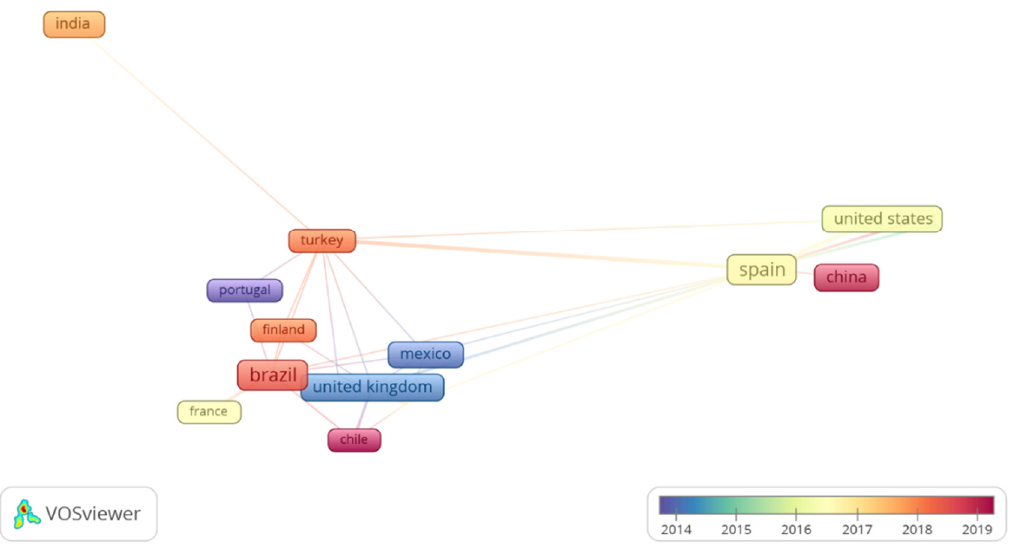
Figure 2. Visualization map of the collaboration network of countries according to co-occurrence over the years. Each frame represents a country. The frame size indicates its frequency of occurrence. The count of citations received by articles that contain the term or phrase by year is represented according to a color scale. The closest frames indicate the terms that co-occurred most frequently over the years.